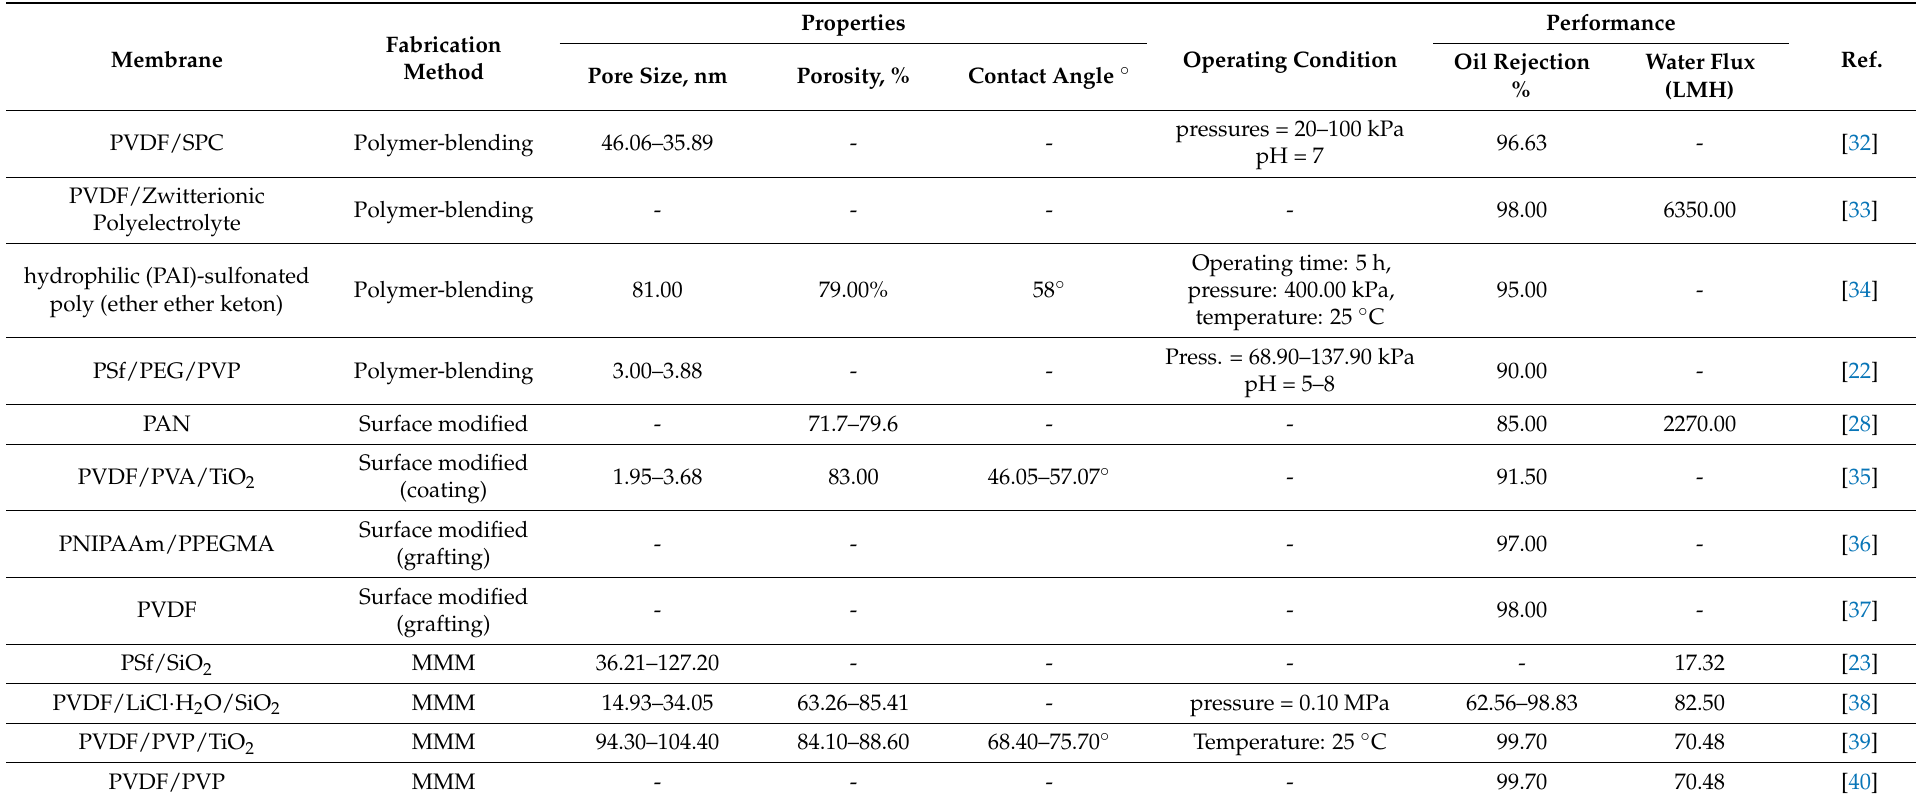
Table 1. Examples of research on the polymer alterations approaches for the polymeric membrane for oily wastewater